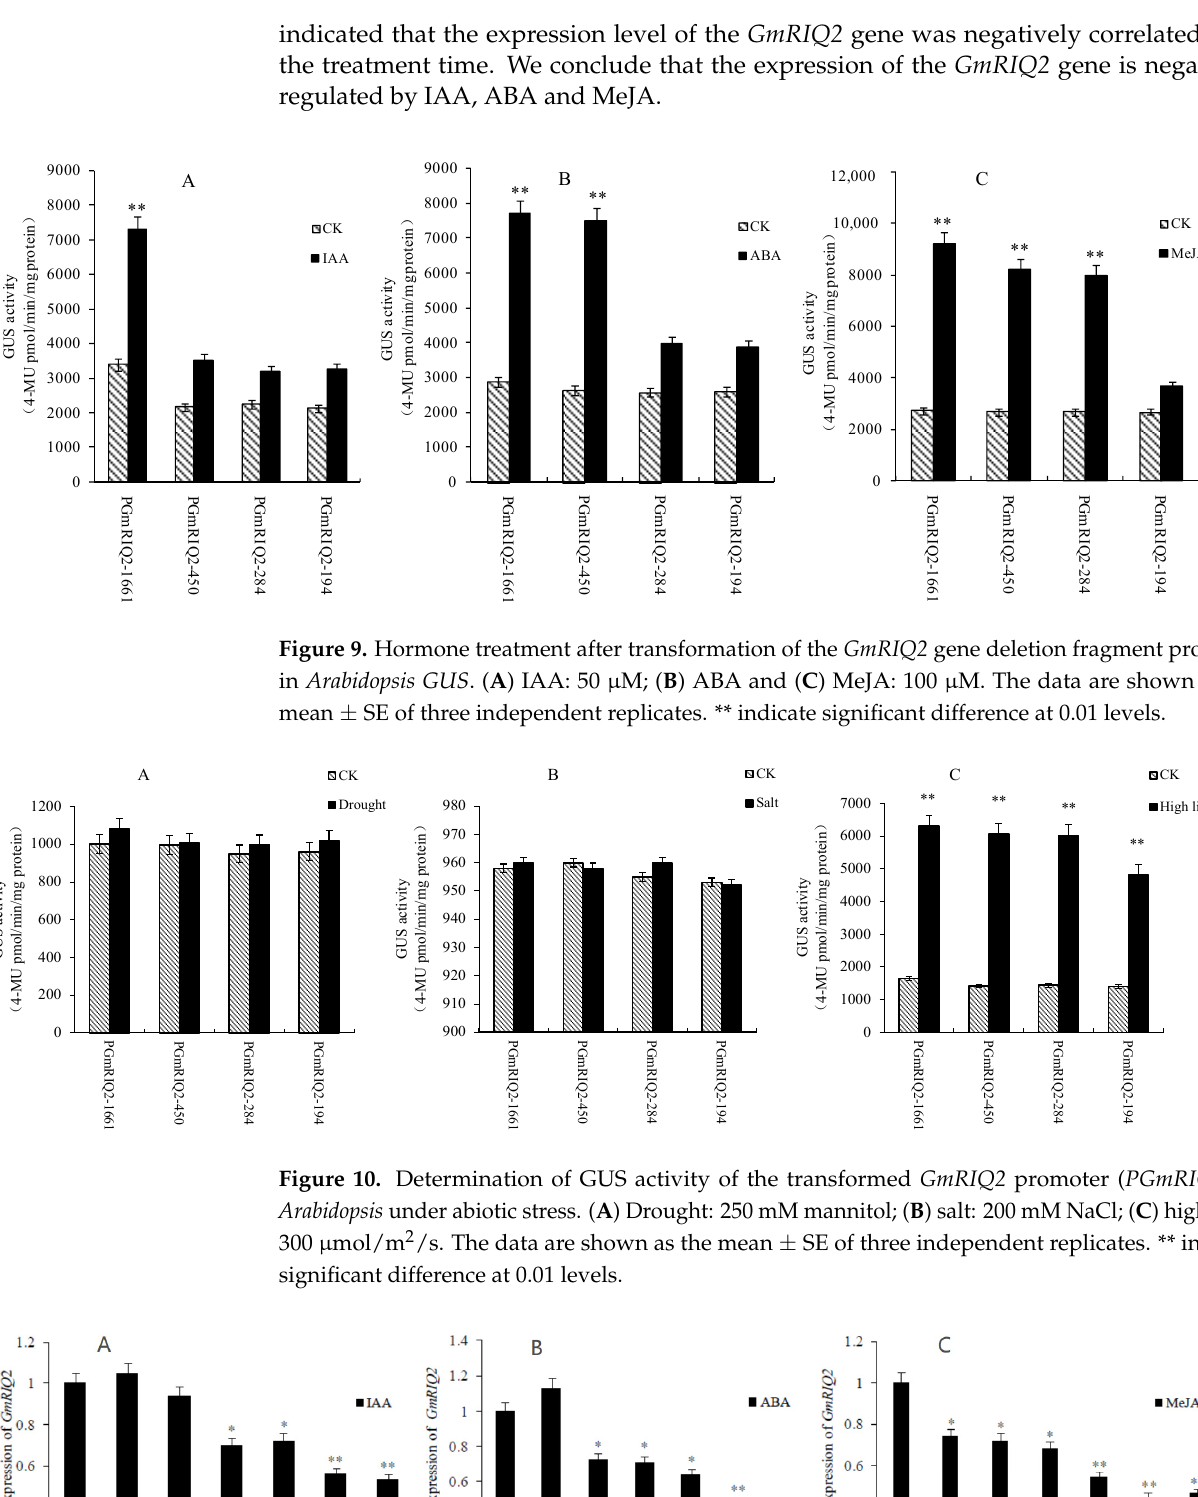
Figure 11. Effects of hormones on the expression levels of GmRIQ2 in soybean KF16. ( A ) IAA: 50 µ M; ( B ) ABA and ( C ) MeJA: 100 µ M. The data are shown as the mean ± SE of three independent replicates. * and ** indicate significant difference at 0.05 and 0.01 levels, respectively